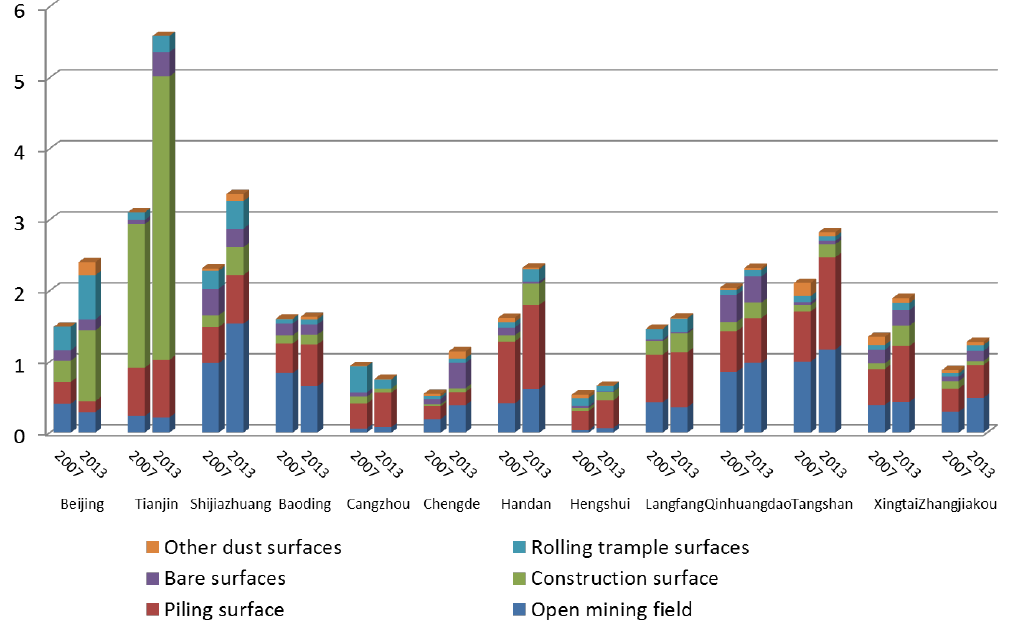
Figure 4. Statistical results of Area Ratio of Dust Surface (ARDS) according to the administrative units (municipalities) from the years 2007 and 2013 in BTH.